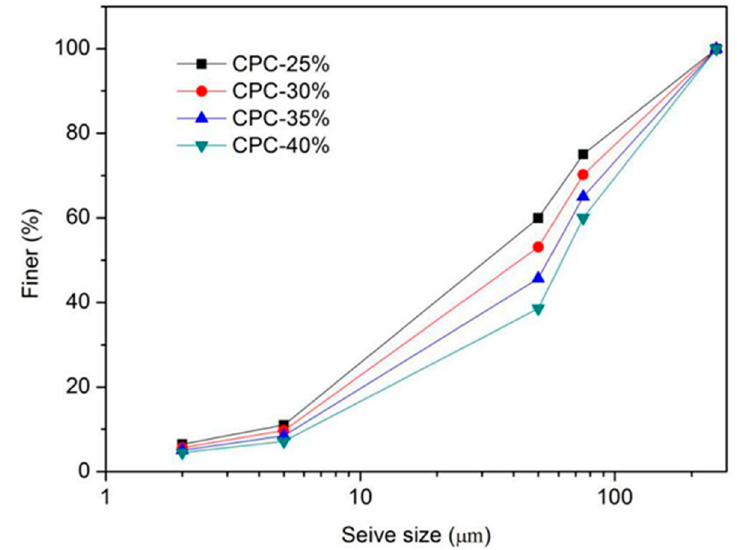
Figure 1. Particle size distribution Figure 1 . Particle size distribution curves . Table 4. Parameters of different coarse particle contents.